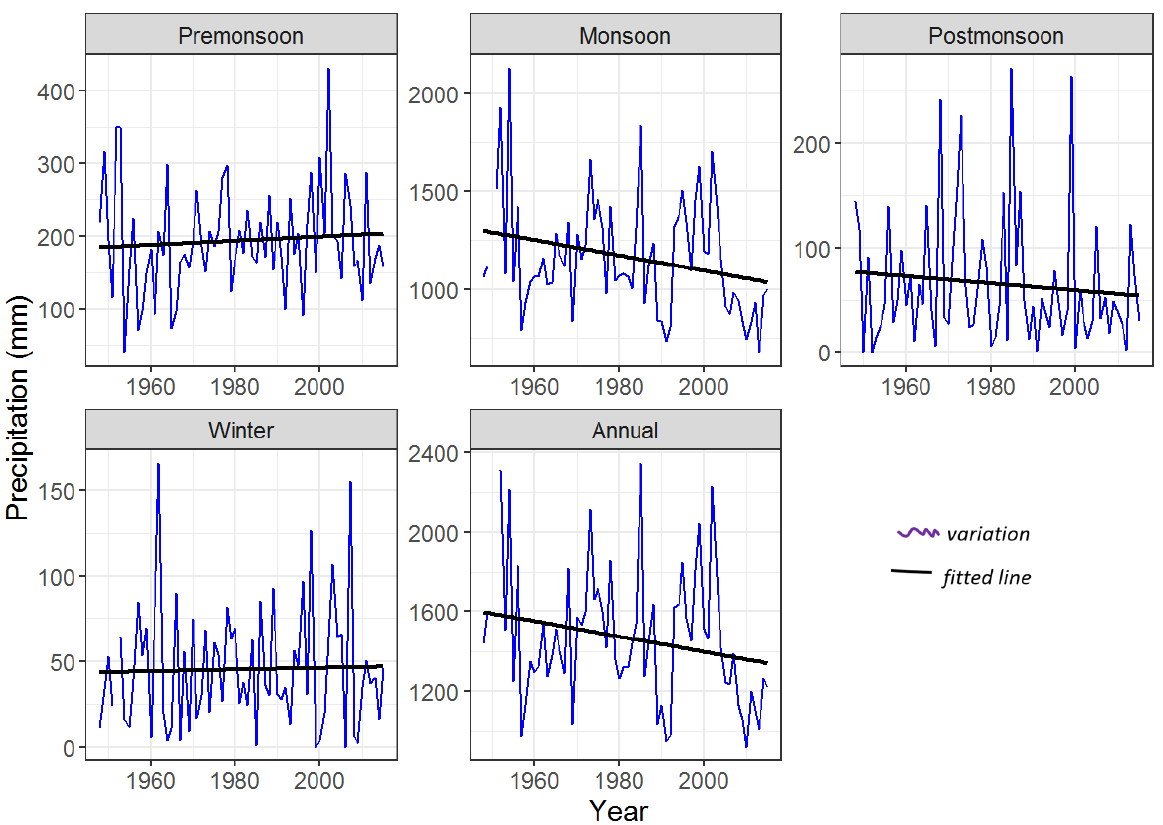
Figure 4. Trends of seasonal and annual total precipitation in the study area.